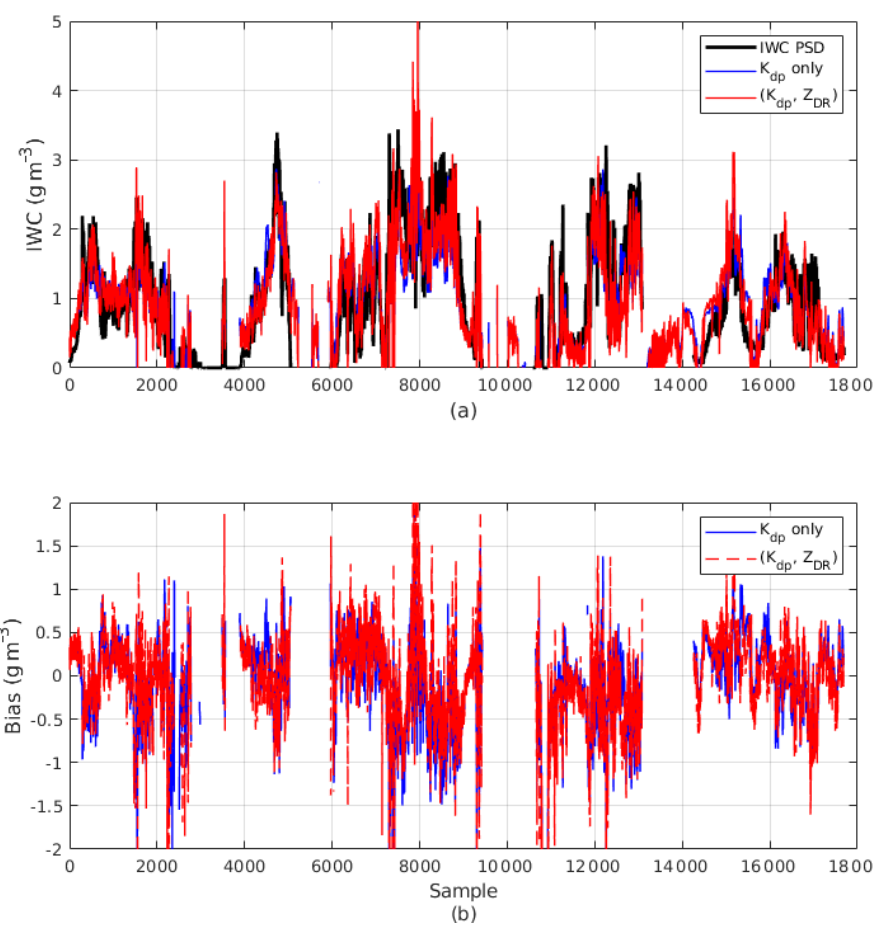
Figure 15. (a) Combined IWC time series data from the selected flights: measured IWC (black line), estimated IWC using K dp alone (blue line), and estimated IWC using K dp and Z DR (red line). (b) Estimation errors for the two estimators. For all study cases, the aircraft flew